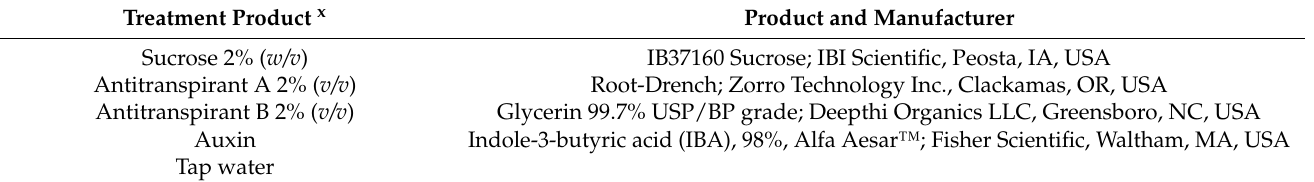
Table 1. List of commercial products that were applied to rootstock cv. Super Shintosa before splice-grafting. Treatment Product x Product and Manufacturer Sucrose 2% ( w/v ) Antitranspirant A 2% ( v/v